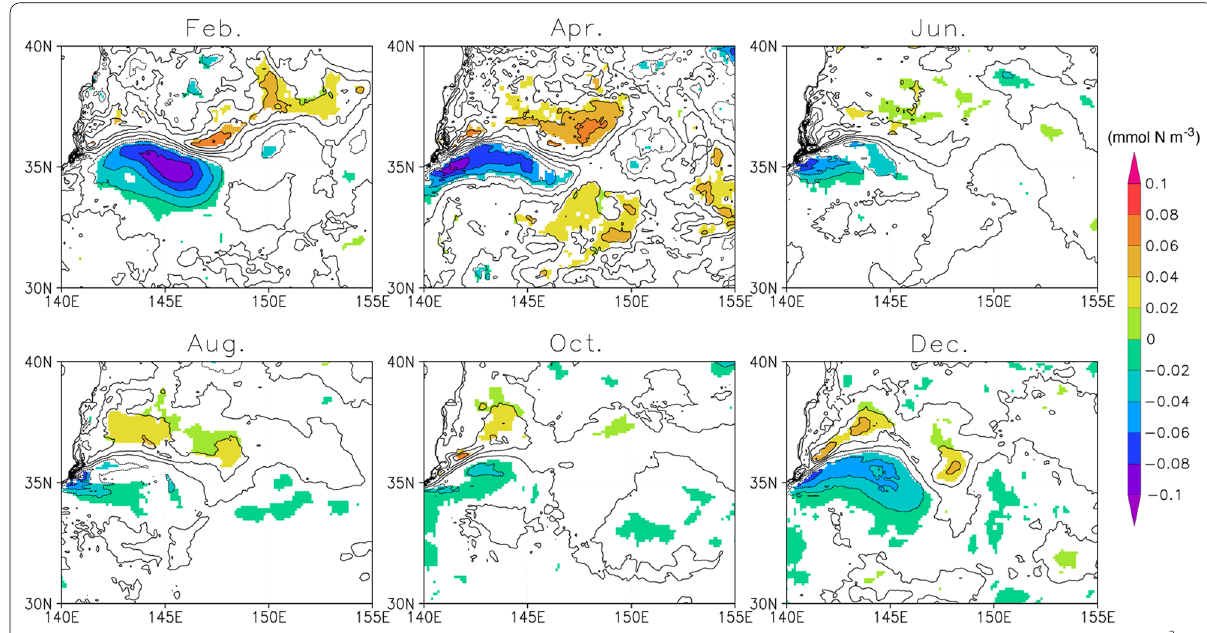
Fig. 4 Composites of phytoplankton concentration anomalies at the surface during the stable states. The contour intervals are 0.02 mmol N m − 3 . Anomalies significant at the 95% confidence level by a two-tailed t test are